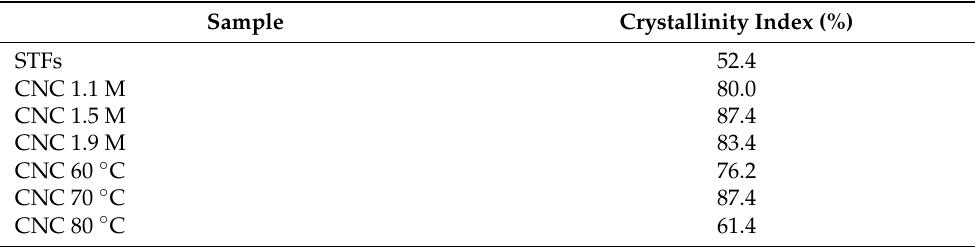
Table 2. Crystallinity index of STFs and CNCs prepared under different APS concentrations at 70 ◦ C for 16 h and under different oxidation temperatures with 1.5 APS concentration for 16